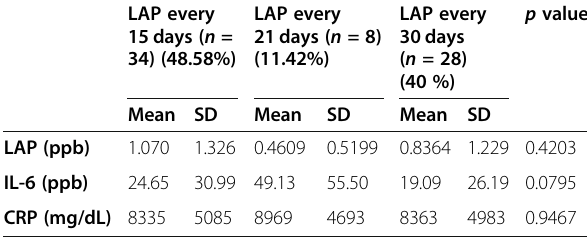
Table 4 Correlation between long-acting penicillin regimen and levels of long-acting penicillin, interleukin-6, and C-reactive